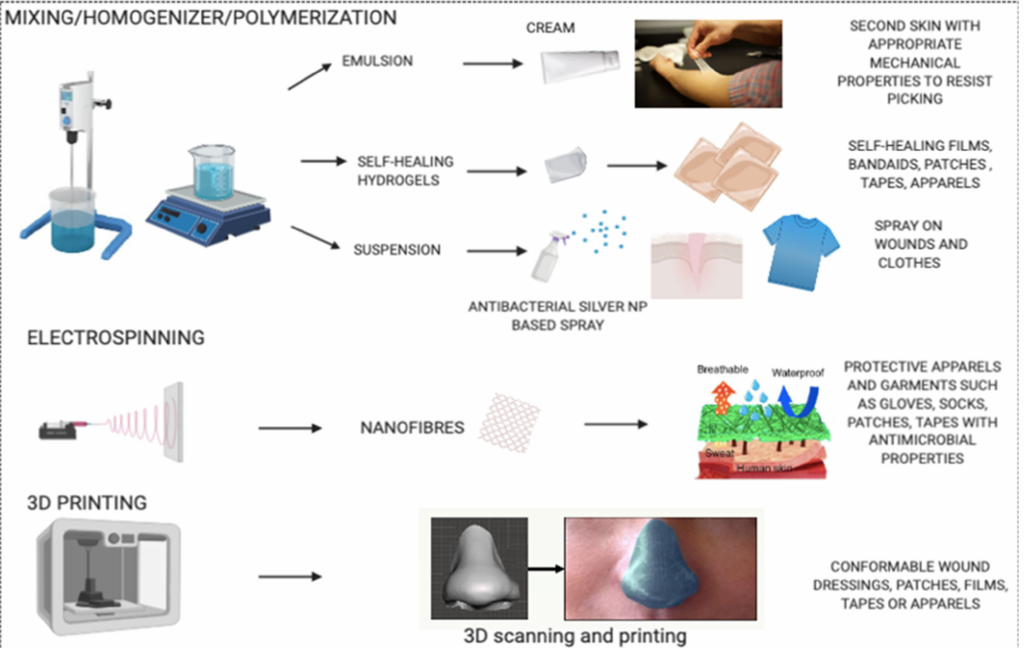
Figure 1. Graphical illustration of the proposed physical barrier strategies and their manufacturing techniques. Modified and assembled via the Biorender software and the Servier medical art